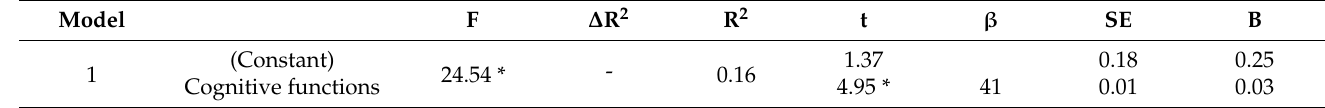
Table 4. Nursing care rationing